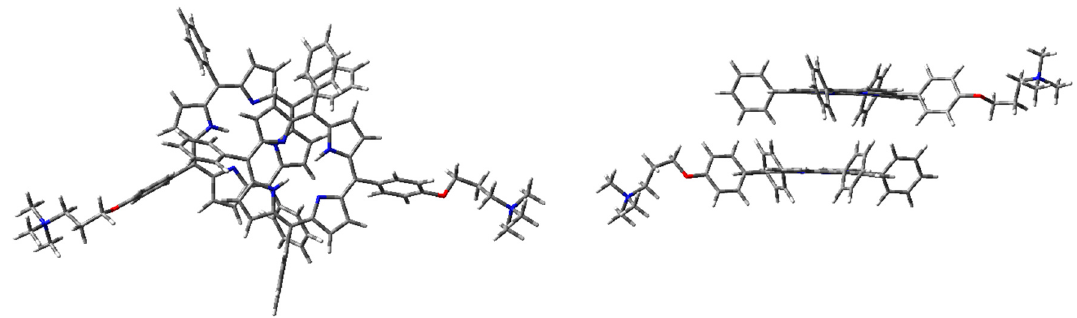
Figure 6. 1H 2 H-type dimer geometry optimization in the vacuum with CAM-B3LYP functional and